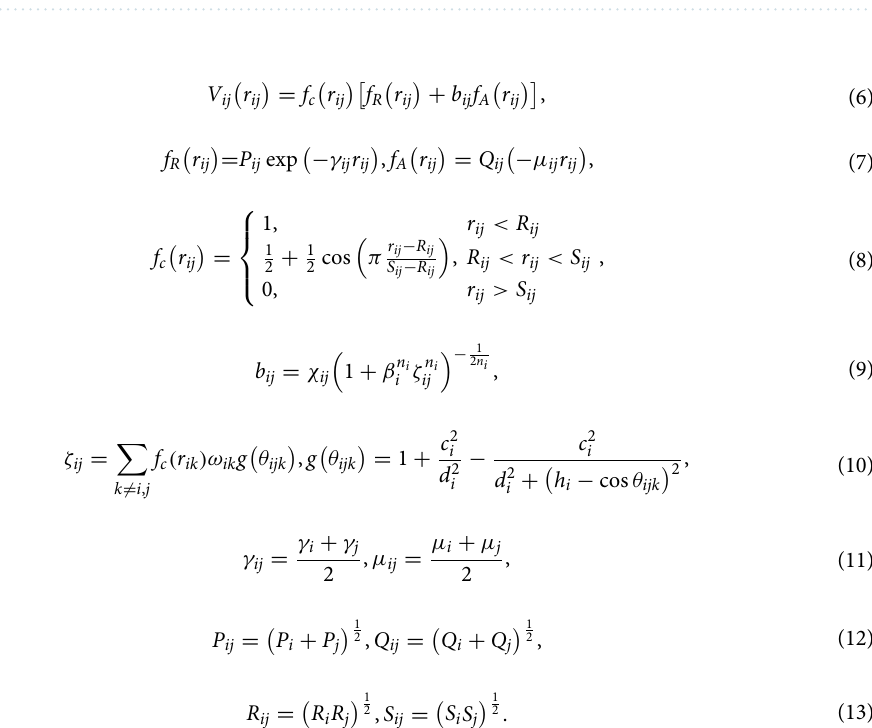
Table 1. Parameters in the BKS + 24-6L-J potential for the solid phase. Parameters in the BKS + 24–6L–J potential for the solid phase are from Ref. 31